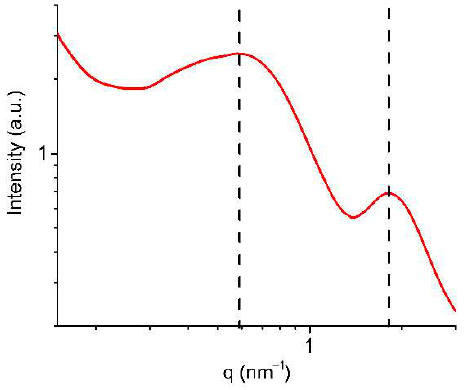
Figure 2. SAXS profile of the water-swollen Nafion ® 212 membrane.